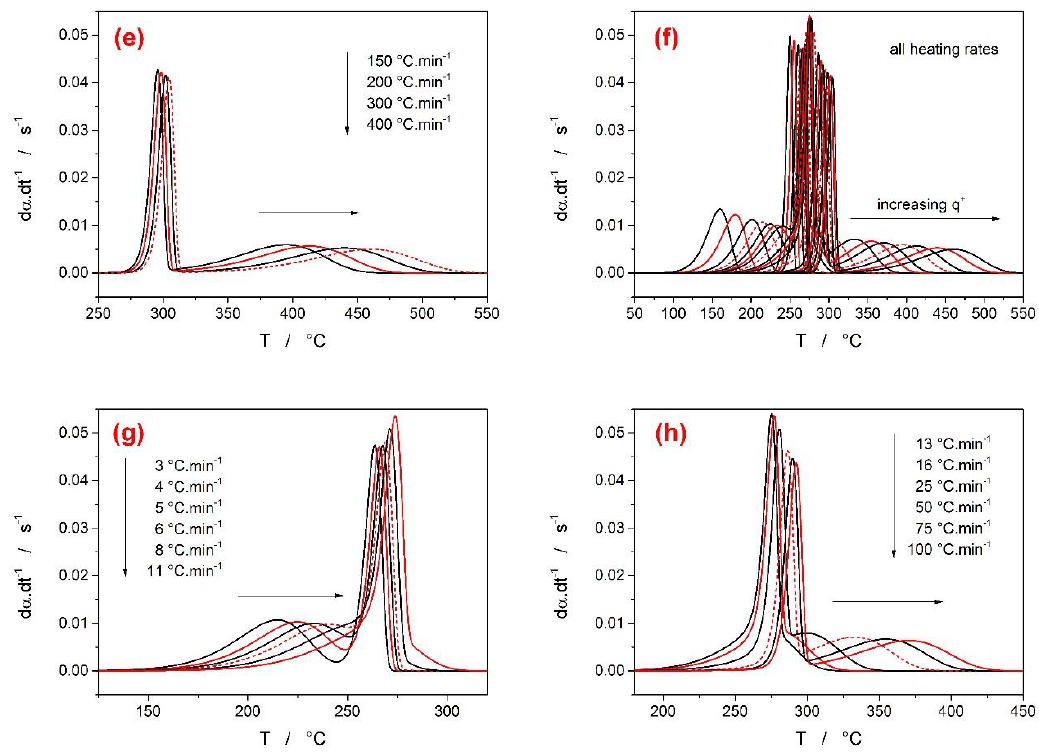
Figure 3. Datasets simulated within the second group of data for the following parameters E 1 = 50 kJ · mol − 1 , E 2 = 300 kJ · mol − 1 , JMA kinetics, m 1 = m 2 = 2, I 1 = I 2 = 0.50, A 1 = 10 2.5 s − 1 , A 1 = 10 27 s − 1 , 10,000 points / curve density. ( a ) set A; ( b ) set B; ( c ) set C; ( d ) set D; ( e ) set E; ( f ) set F; ( g ) set G; ( h ) set H.